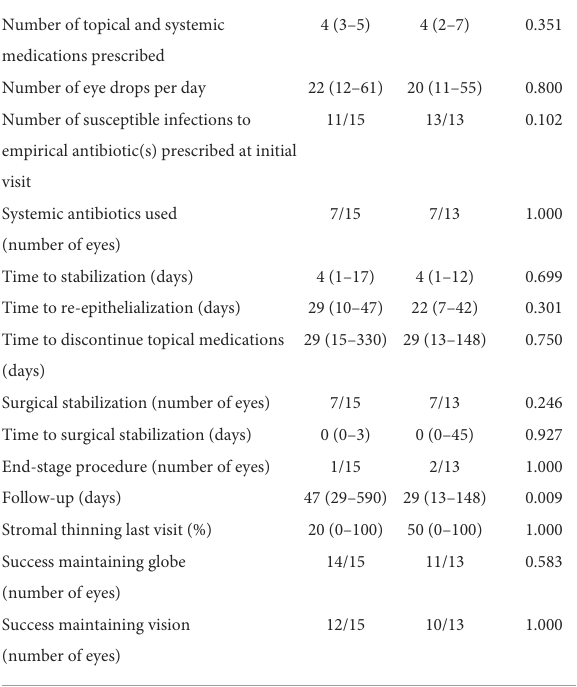
TABLE 3 Summary of therapeutics and clinical outcomes from 28 canine patients and associated corneal ulcers infected with Staphylococcus pseudintermedius